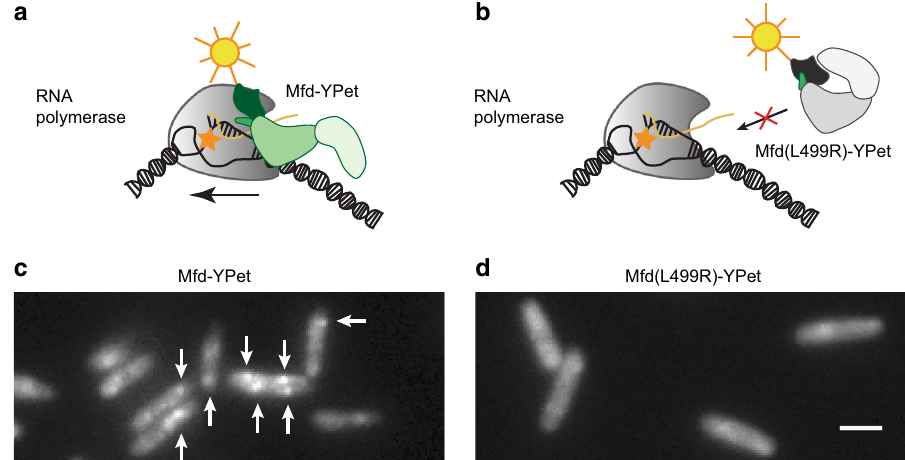
Fig. 2 Mfd-YPet associates with the nucleoid via interactions with RNA polymerase. Schematic describing the initial stages of transcription-coupled repair. a Mfd is recruited to RNA polymerase stalled at bulky lesions (orange star) on the transcribed strand. The arrow indicates the direction of transcription elongation by RNA polymerase. b Substitution of L499 residue with arginine (R) results in the mutant Mfd(L499R) that is unable to rescue stalled transcription complexes. Fluorescence images of Δ mfd cells expressing plasmid-based c wild-type Mfd-YPet or d mutant Mfd(L499R)-YPet. White arrows highlight well-de fi ned Mfd-YPet foci. Each image is an average projection of ten continuous 100-ms frames. Scale bar, 2 µ m